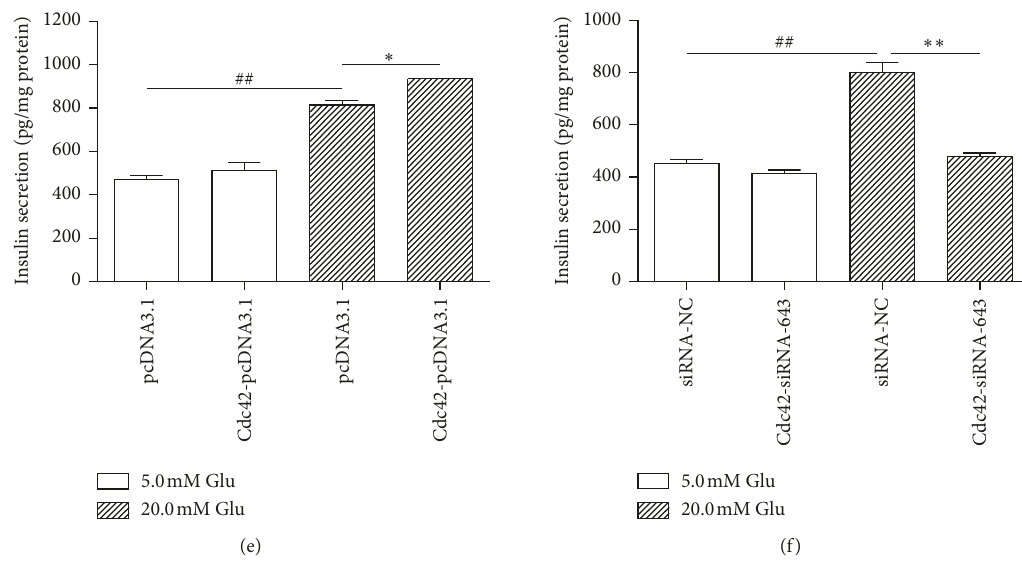
Figure 2: Effects of Cdc42 on MIN6 cells. (a) Effects of Cdc42-pcDNA3.1 on Cdc42 expression in MIN6 cells. Western blot to detect Cdc42 protein expression after transfection with Cdc42-pcDNA3.1 ( n � 3). ∗ P < 0 . 01, compared with pcDNA3.1 group, as assessed by paired Student’s t -test. (b and c) Screening of Cdc42-siRNA fragments. (b) RT-PCR to detect Cdc42 mRNA expression after transient transfection with different siRNA fragments ( n � 3). ∗ P < 0 . 05 and ∗∗ P < 0 . 01, compared with siRNA-NC group, as assessed by paired Student’s t -test. (c) Western blot to detect Cdc42 protein expression after transient transfection with different siRNA fragments ( n � 3). ∗∗ P < 0 . 01, compared with siRNA-NC group, as assessed by paired Student’s t -test. (d) Effects of Cdc42 on MIN6 cell proliferation. CCK assay to detect MIN6 cell proliferation after transfection with Cdc42-siRNA and Cdc42-pcDNA3.1 ( n � 3). ∗∗ P < 0 . 01, compared with siRNA-NC group, # P < 0 . 01, compared with pcDNA3.1 group, as assessed by one-way ANOVA, followed by Fisher’s least significant difference test. (e and f) Effects of Cdc42 on insulin secretion by MIN6 cells. ELISA to detect insulin secretion levels in MIN6 cells after transient transfection with Cdc42-pcDNA3.1 and Cdc42-siRNA under basal-glucose (5.0 mM) and high-glucose (20.0 mM) stimulation 5.0 mM glucose group, as assessed by paired Student’s t -test. Data are shown as mean ± SD. NC: negative